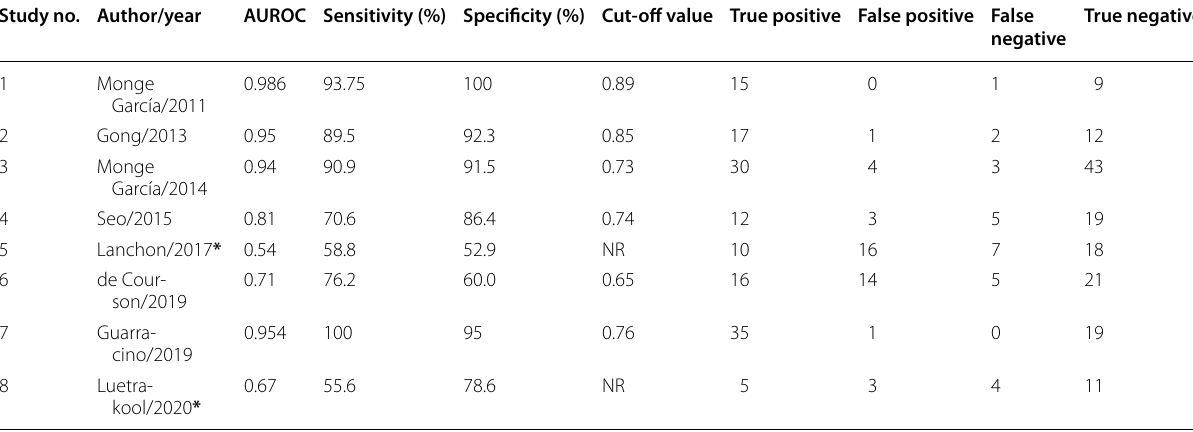
No. number, MAP mean arterial pressure, AUROC area under the receive operator characteristic curve, NR no record * The study failed to identify the predictive ability of dynamic arterial elastance. These two studies only reported the AUROC value. Thus, we returned to the original ROC curve in their article to identify the cut-off point and estimate its corresponding sensitivity and specificity Subgroup analysis and sensitivity analysis